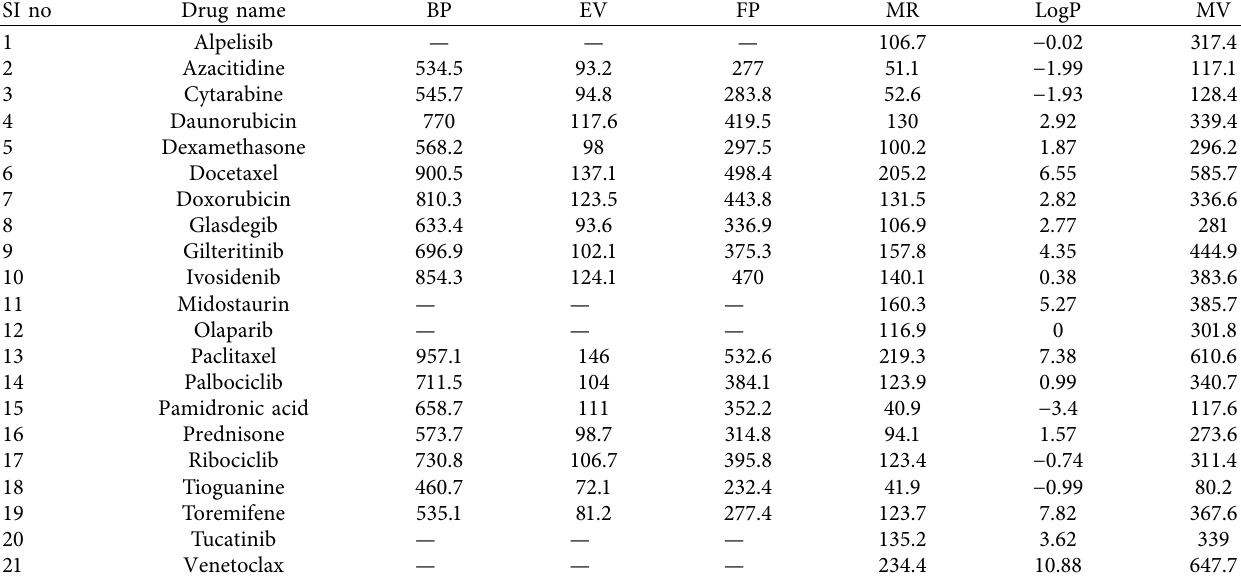
Table 2: Physicochemical properties of breast cancer